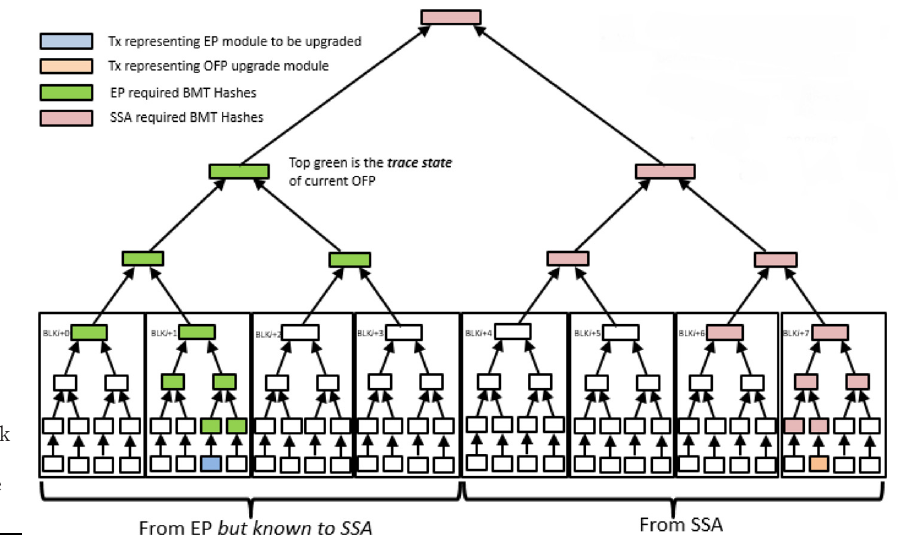
Figure 8. Illustration of a bridging multi-block PBMT (BMP) that represents a